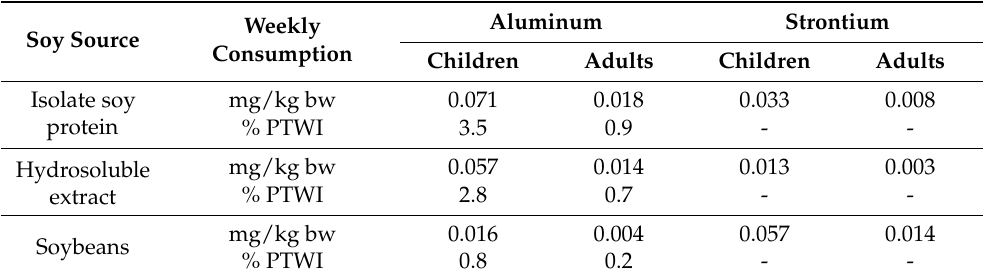
Table 5. Estimative of Al and Sr dietary exposure, considering a daily intake of one glass (200 mL) of soy-based